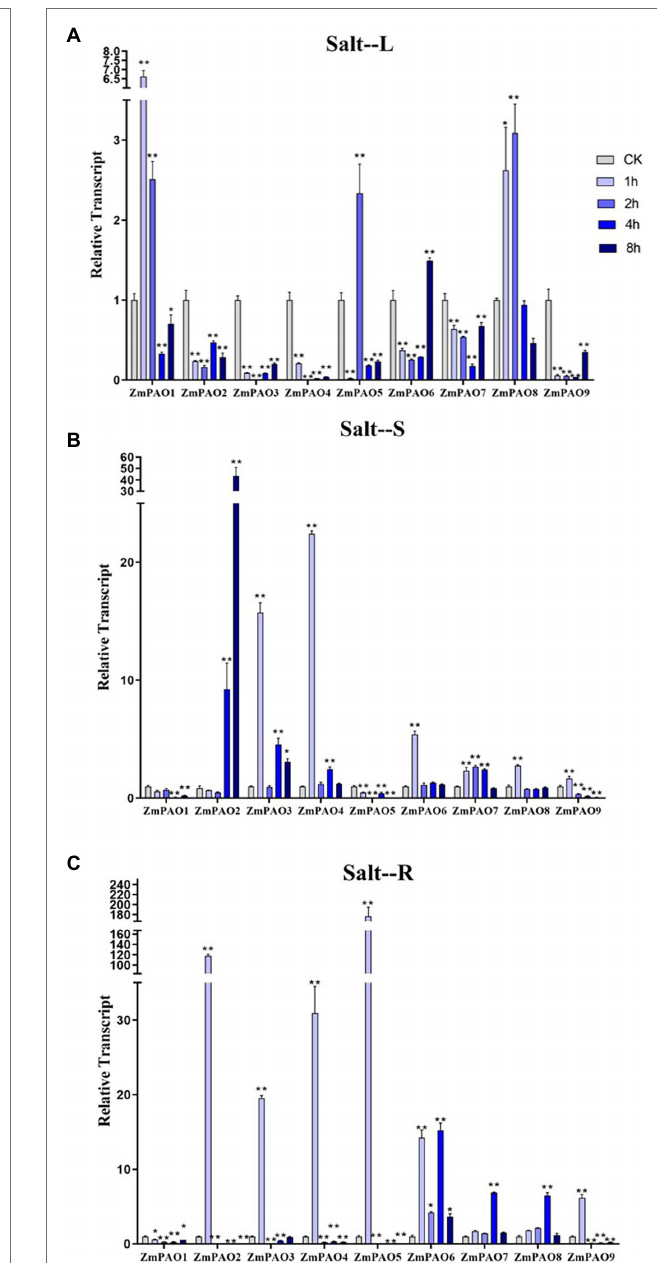
FIGURE 7 | Expression profiles of ZmPAO genes under heat stress treatment in different tissues. qRT-PCR data was normalized using ZmActin gene. (A–C) Expression profiles of ZmPAO genes under heat treatment (42 ° C) in leaves, stems, and roots, respectively. Error bars are caused by three biological replicates. Asterisks above the error bars represent statistical significance using one-way ANOVA and a Fisher’s least significant difference (LSD). * Significantly different at p < 0.05; ** significantly different at p < 0.01.